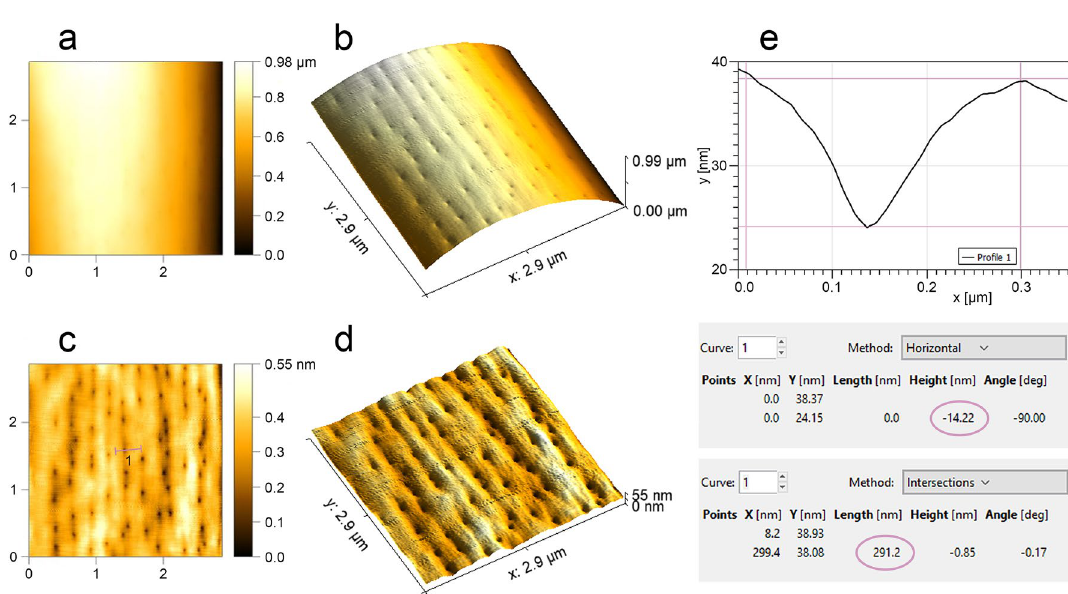
Figure 8. Detailed analysis of sensillum type M5 ( L. occidentalis ) in AFM: the surface of sensillum before ( a , b ) and after subtracting the sample curvature ( c , d ); profile of single pore ( e